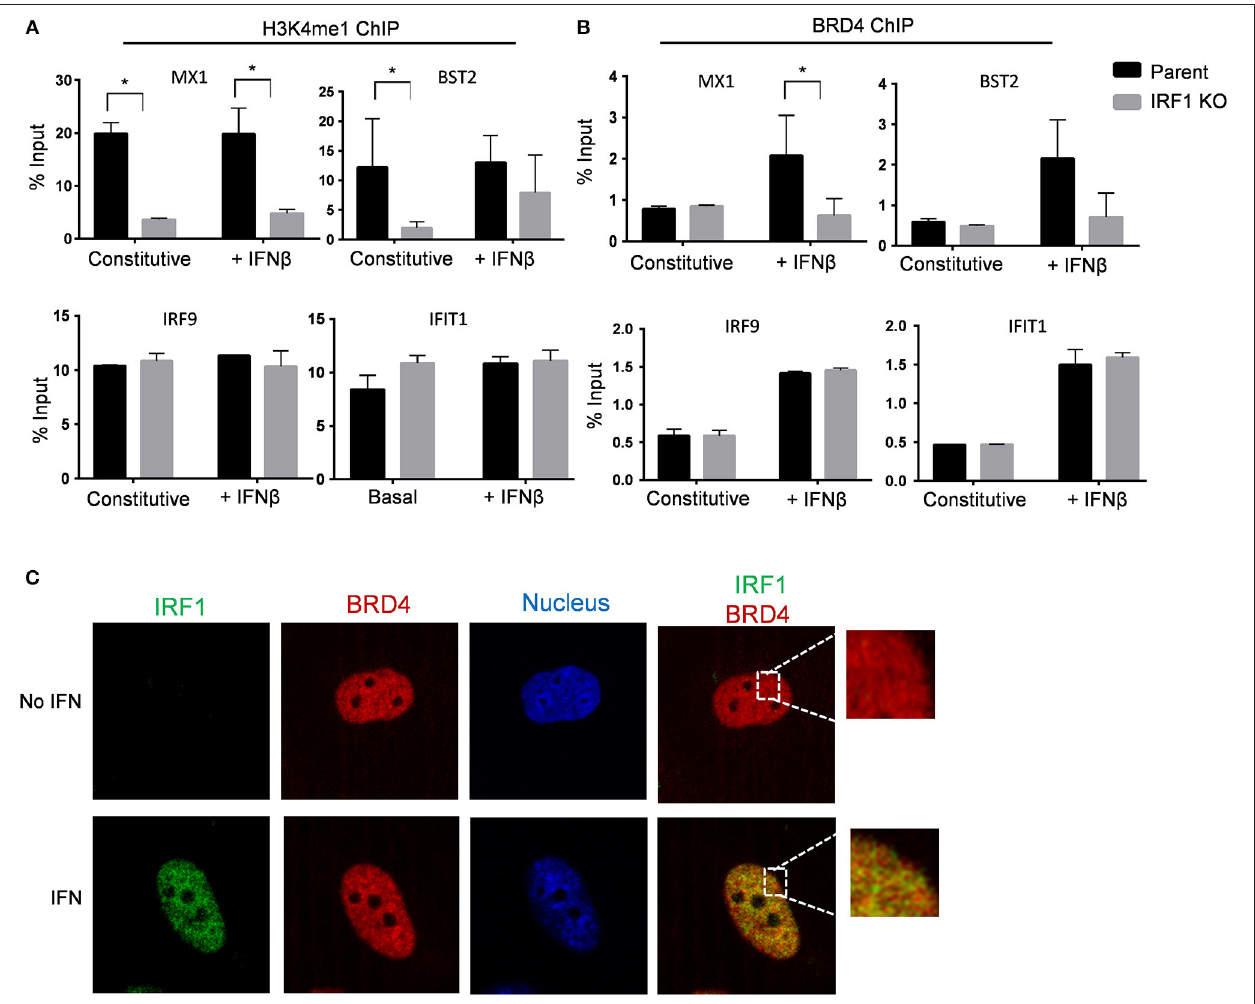
FIGURE 8 | IRF1 dependent H3K4me1 occupancy and recruitment of BRD4 on promoters of IRF1 dependent ISGs. Parent and IRF1-KO cells were treated with IFN β or left untreated. Chromatin immunoprecipitation was done using H3K4me1 (A) and BRD4 (B) antibodies. The promoter regions harboring potential IRF1 binding sites of IRF1 dependent genes (MX1 and BST2) and IRF1 independent genes (IRF9 and IFIT1) were analyzed. Percent input (mean ± standard deviation of two biological replicate experiments and three technical replicate PCRs) is expressed as relative enrichment over input (right axis) at steady state and upon IFN β treatment. (C) BEAS-2B cells were either treated with IFN β or mock treated and then processed for confocal microscopy to examine localization of BRD4 and IRF1. Images from individual channels for IRF1 (green), BRD4 (red), and nuclei (blue) are shown. Right panels show images with merged channels with magnified view as inset. *Statistically